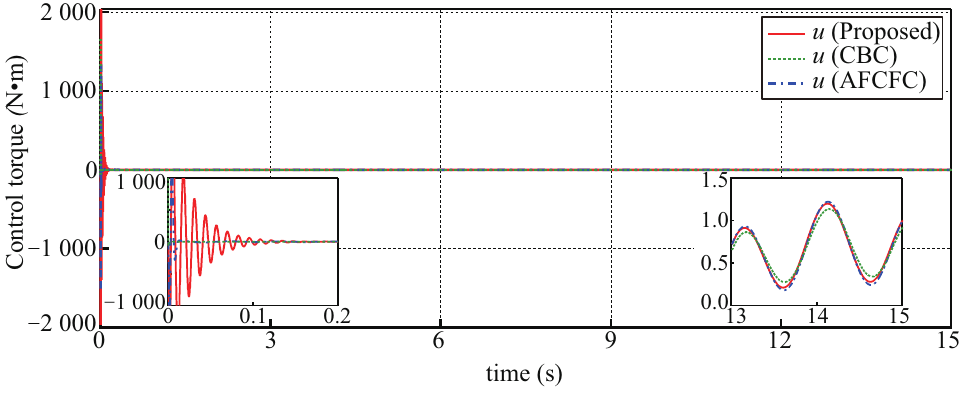
Figure 13. Control torque u under the three controllers.